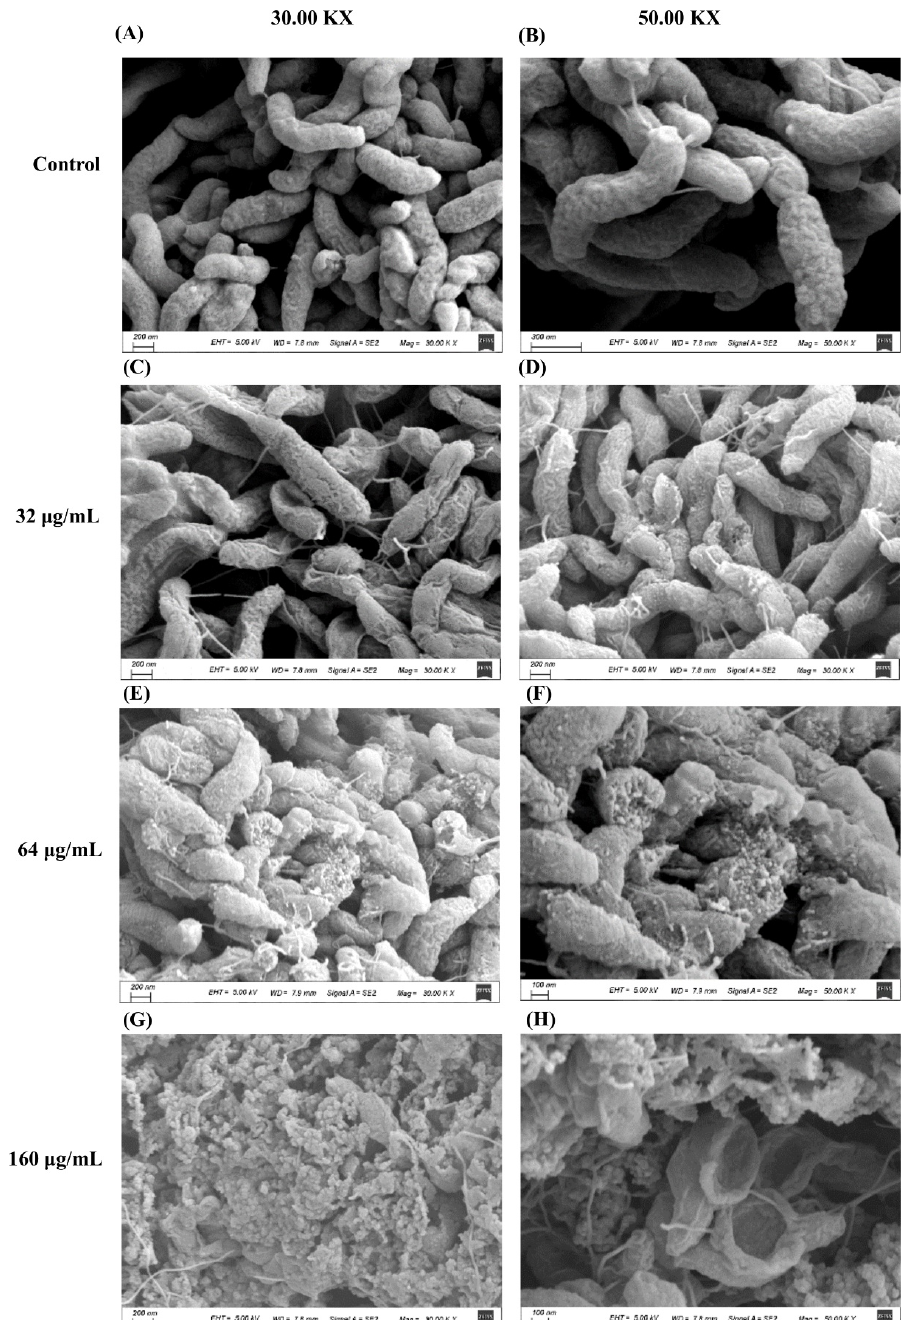
Figure 2. Scanning electron microscopy photography of C. jejuni strain 81-176 planktonic cell under DATS treatment and the control after 24 h. The control was C. jejuni culture without DATS treatment ( A , B ). The treatment concentrations of DATS included 32 μ g/mL ( C , D ), 64 μ g/mL ( E , F ) and 160 μ g/mL ( G , H ). An MTT(3-(4,5-Dimethylthiazol-2-yl)-2,5-diphenyltetrazolium bromide) cell viabil- at the 16 μ g/mL (0.5× MIC), about 98% of cells were viable, while at the 32 μ g/mL (1× MIC)